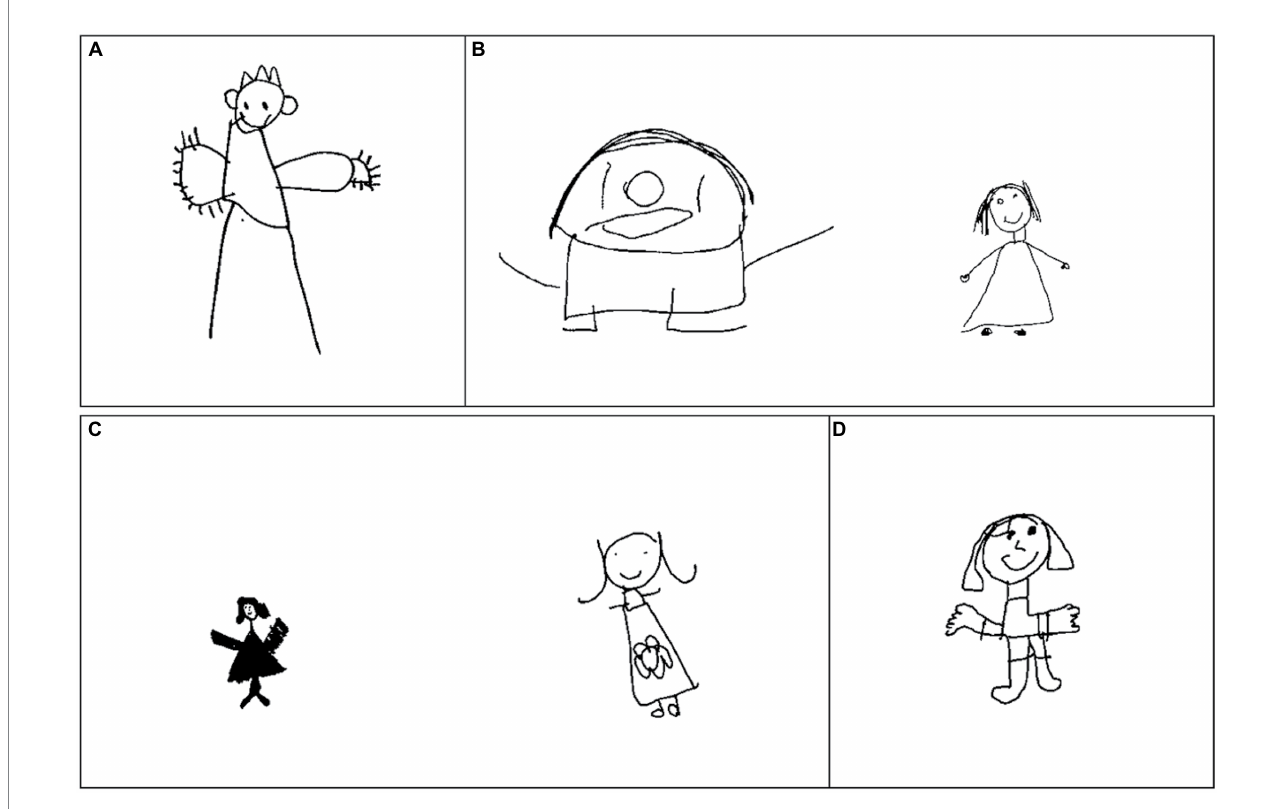
FIGURE 2 Limitations of the Draw-A-Child 12-item checklist. Examples of children’s drawings that demonstrate the limitations of the Draw-A-Child 12-item checklist. (A) Figure with lines that may suggest fingers extending from shapes that may constitute hands, but the Draw-A-Child checklist includes no way to indicate that there are too many fingers; (B) Two figures that each score a 9 on the Draw-A-Child checklist where the participant’s ability appears unequal; (C) Two figures that suggest different levels of pressure applied when making drawing; (D) Figure that presents with out of proportion